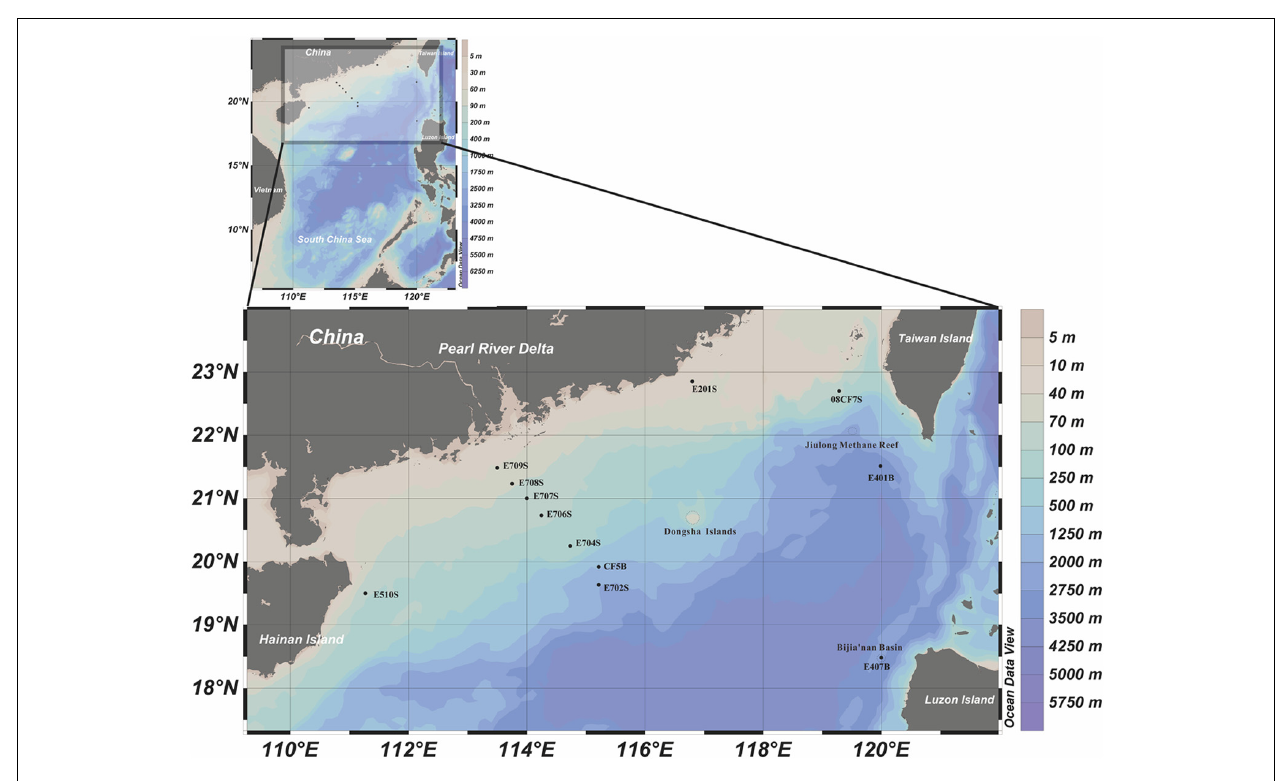
FIGURE 1 | Geographic locations of sampling sites in the northern South China Sea (nSCS). This illustration was made with Ocean DataView 4.0 software (http://odv.awi.de/). Methane reef location and prospective methane hydrate harboring places were circled with dash lines.